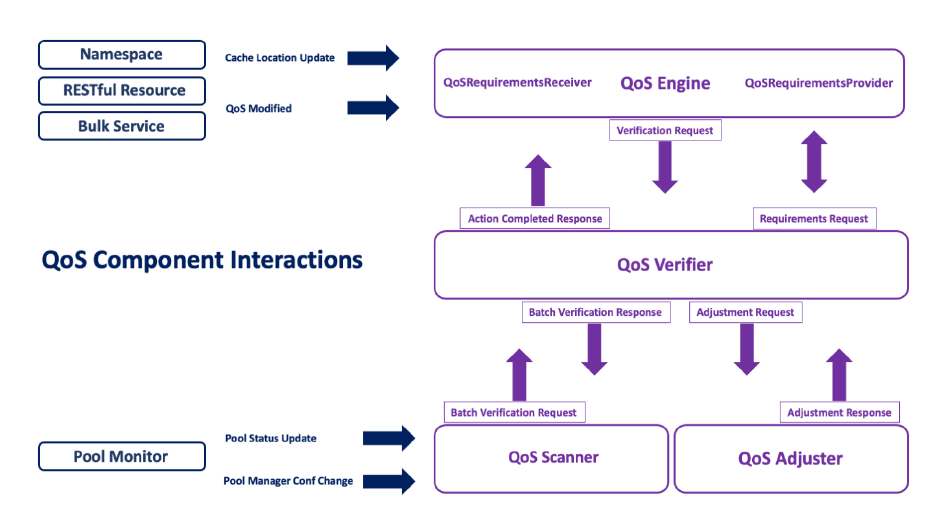
Figure 4. QoS Component